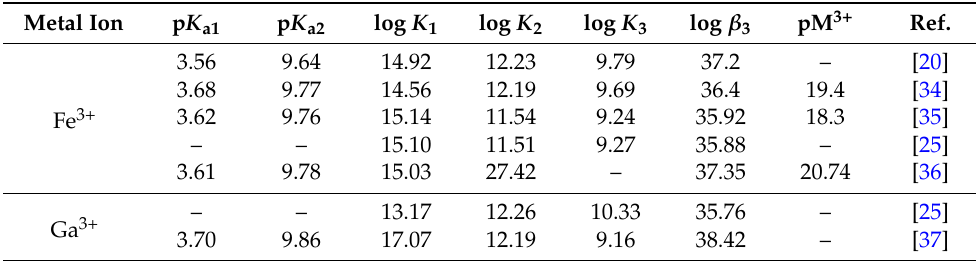
Table 2. Protonation constants and Fe 3+ and Ga 3+ stability constants for deferiprone ( 1 ) (measured at 22.5–25 °C, ionic strength 0.1–0.2 M; for pM values, pH 7.4, with [total ligand] = 10 − 5 M and [total metal ion] = 10 − 6 M).